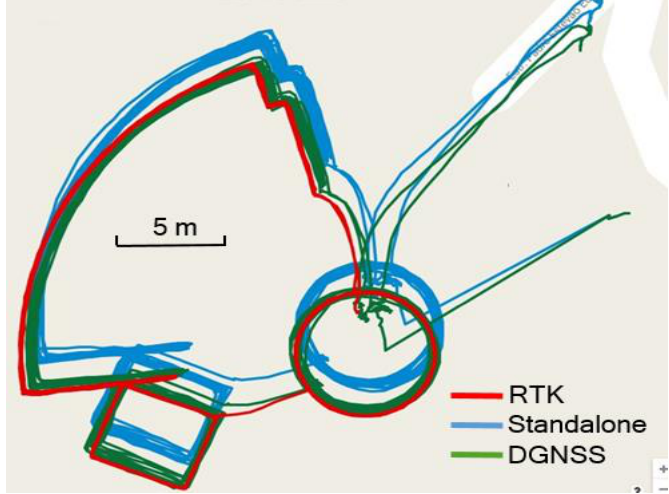
Figure 5. Positioning results in the open area, the trajectories of real-time kinematic positioning (RTK) receiver (red line), GNSS (blue line) and DGNSS (green line) from the Unistrong smartphone.